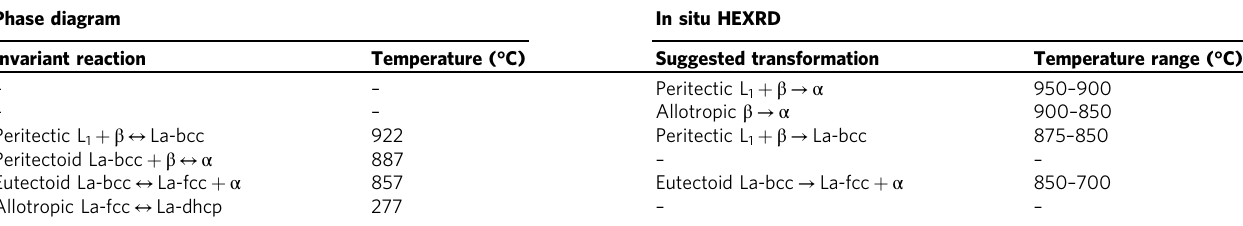
Table 1 Equilibrium invariant reactions according to the current knowledge of the equilibrium phase diagram 29,50 for the Ti-2wt. % La alloy (Ti-2La) contrasted with the transformations identi fi ed in situ (Fig. 4), using high-energy synchrotron X-ray diffraction (HEXRD) during cooling from 950 °C (L 1 + β fi eld) with 20 °C min −